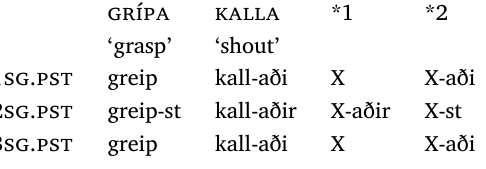
Select inflected forms of Icelandic verbs: three paradigm cells with two allomorphs each. 1 and 2 are logically possible but unattested classes